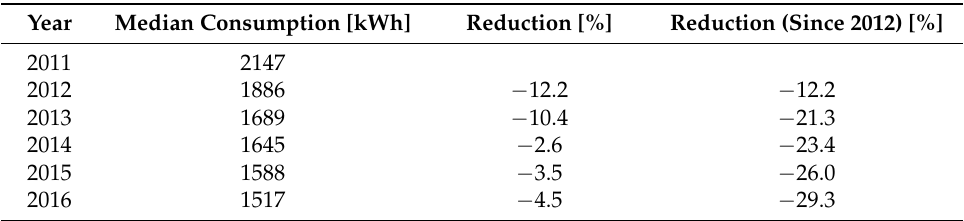
Table 7. Median actual consumption.